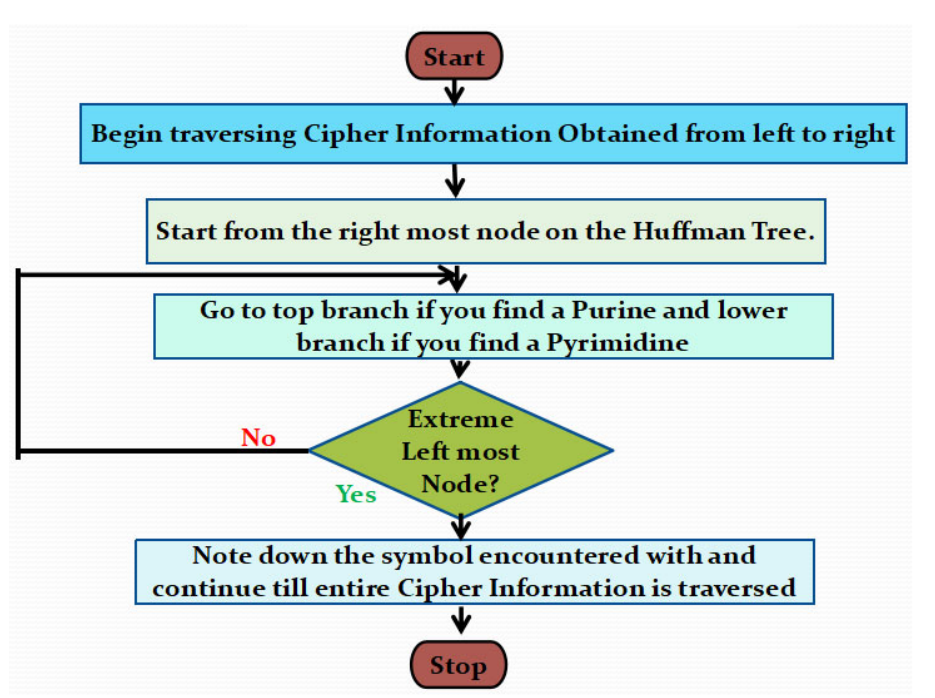
Figure 9. Flowchart of Original Information Retrieval Scheme.